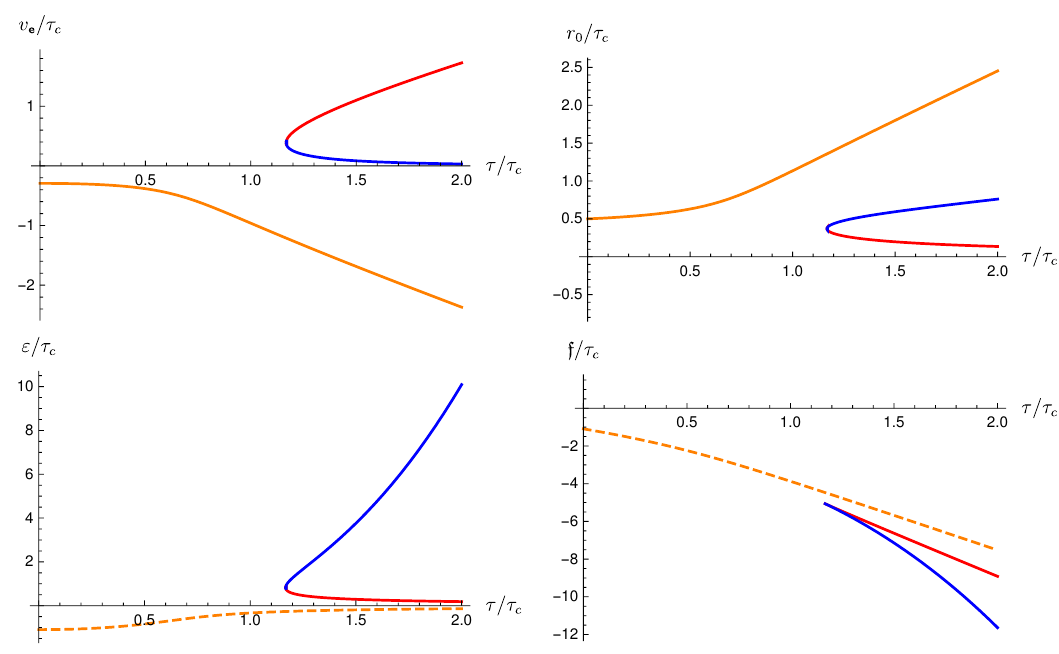
Figure 4 . Plot of the solutions of (6.24) for (cid:26) = 0 : 786 (cid:26) c , together with the corresponding energy " and Helmholtz free energy f densities.